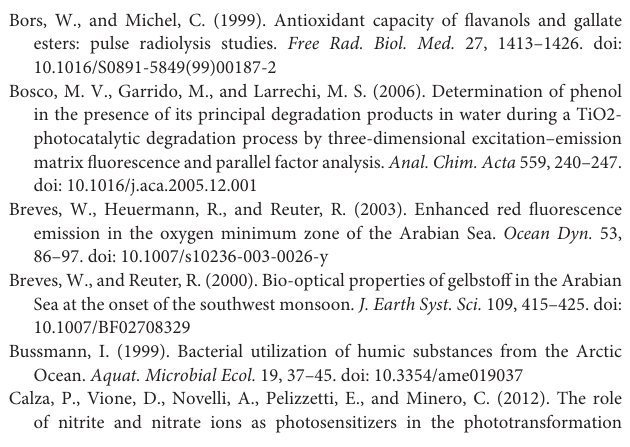
wavelengths but there was no apparent correlation with oxygen concentrations ( Figure 8 ) and the signal appeared to be related more to soluble pigments released in the photic zone presumably by zooplankton grazing (Kleppel,